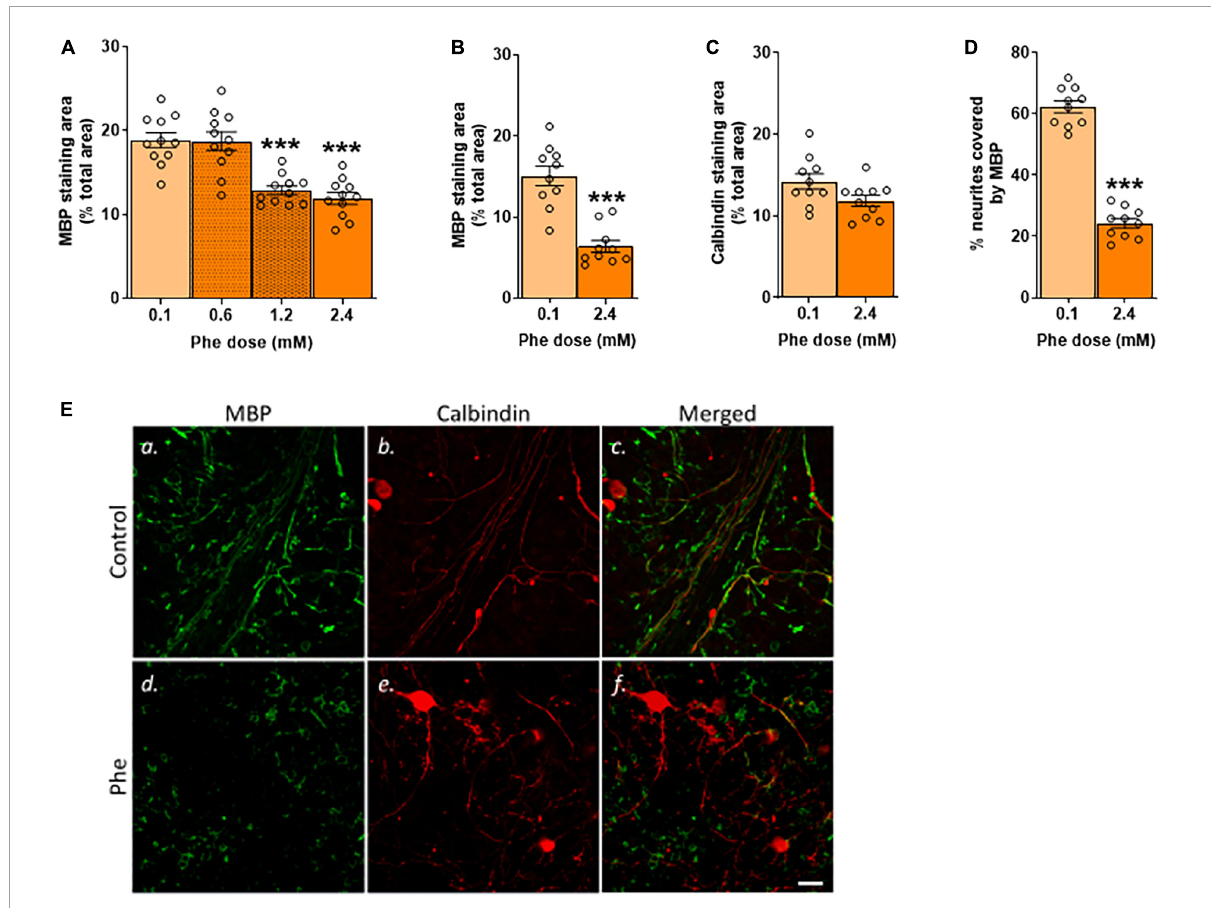
FIGURE2 Only after 21 DIV were the highest doses of phenylalanine deleterious to MBP staining. (A) Cerebellar slices were incubated in control or Phenylalanine (Phe)-supplemented medium for 21 days in vitro (DIV) at 0.1, 0.6, 1.2, and 2.4 mM. Results are presented as the area covered by myelin basic protein (MBP) staining as % of the total area of the field of view. Data are plotted as Mean ± SEM of N = 10 slices/treatment group. (B–D) Cerebellar slices were incubated for 21 DIV in a control medium (0.1 mM Phe) or a medium containing 2.4 mM Phe. The graphs show the results of the immunohistochemistry quantification: (B) Mean area covered by MBP staining as % of the total area of the field of view; representative images are shown in panels ( E a,d); (C) Mean area covered by calbindin staining as % of the total area of the field of view; representative images are shown in panels ( E b,e); (D) % of neurites stained for MBP; representative images are shown in panels ( E c,f). Data are plotted as Mean ± SEM of N = 10 slices/group. Scale bar = 20 µ m. Statistical symbols indicate significance at ∗∗∗ P <